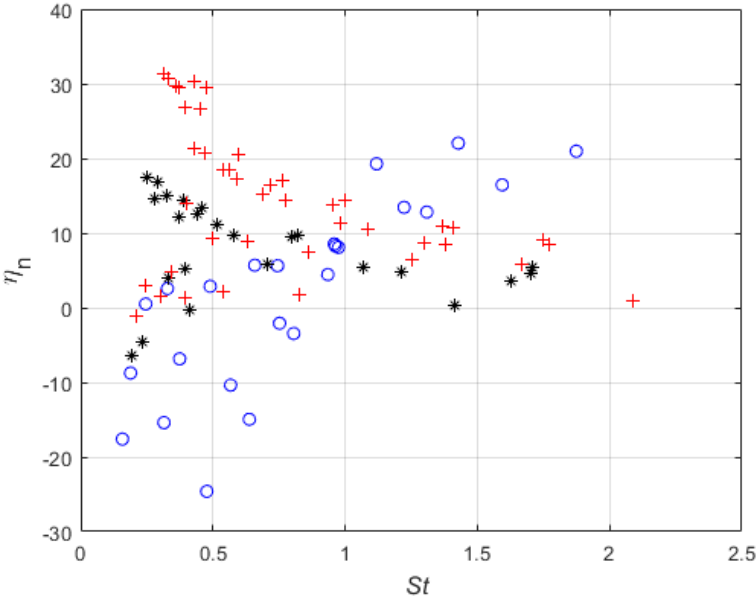
Figure 10. The net propulsive efficiency as a function of the Strouhal number for fins: + made from polycarbonate, o with an additional joint, and ∗ made from a thin steel